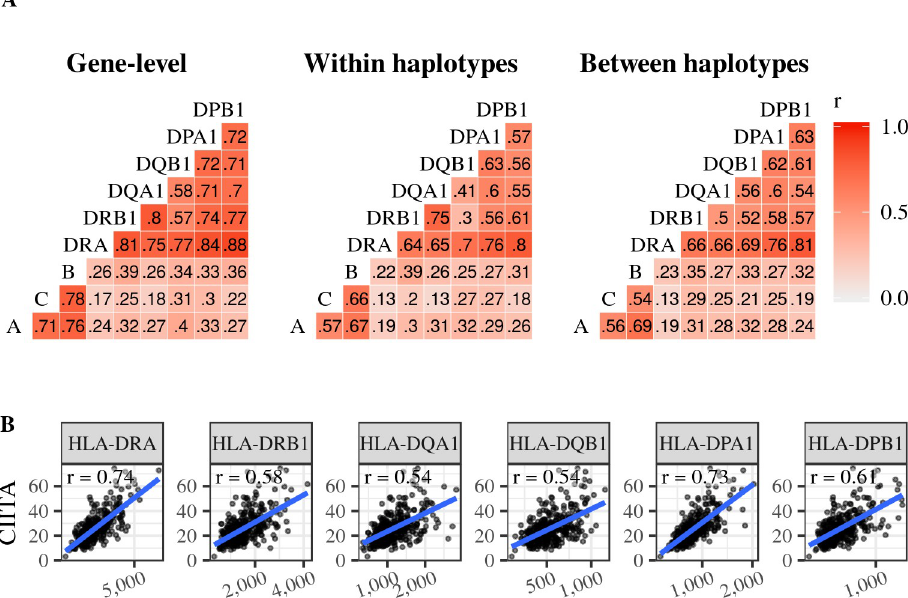
Fig 8. Co-expression patterns for HLA genes. A: Pairwise correlation of expression estimates at the gene-level, for alleles from within the same haplotype, and for alleles on different haplotypes. B: An example of a factor that contributes to correlation of expression at the gene level. CIITA is located on chromosome 16, and its protein regulates the expression of Class II genes. r: Pearson correlation coefficient.